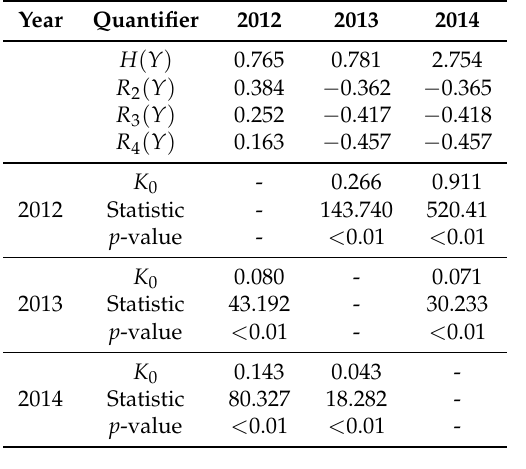
Table 2. SRG Shannon, H ( Y ) , and Rényi, R α ( Y ) , α = 2,3,4, entropies for SST data. For each